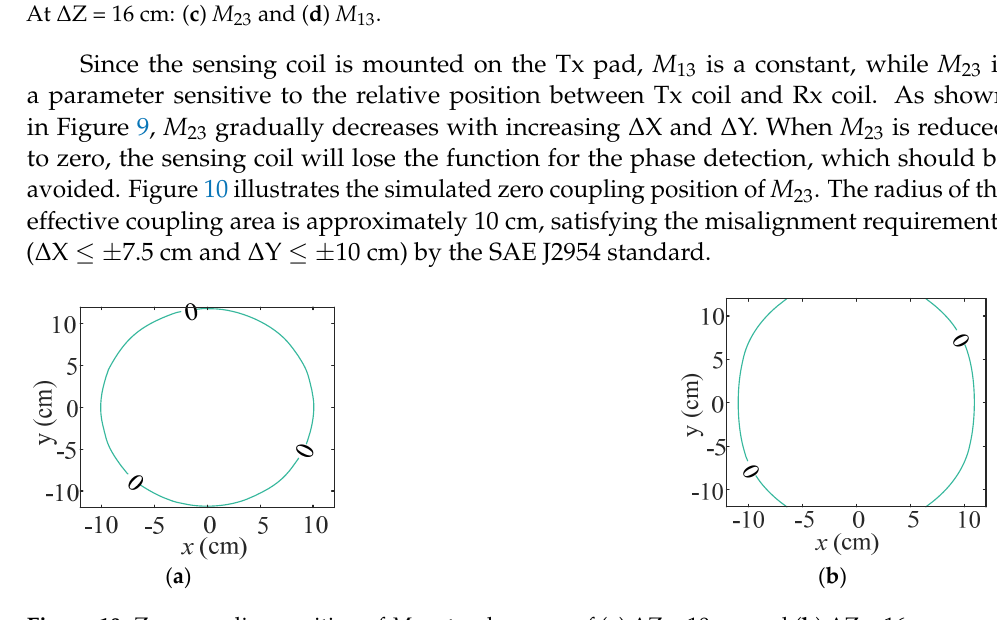
Figure 11. Photo of the prototype. Table 2. IPT prototype parameters. Components